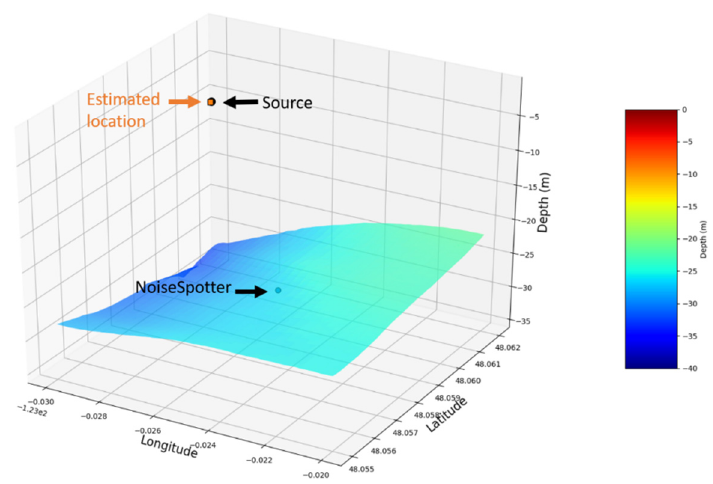
Figure 10. True (black) and estimated (orange) controlled source locations relative to the NoiseSpotter V3 (blue), which were separated from the source by 200 m. The difference between true and estimated locations is 3.6 m (2% of separation distance).